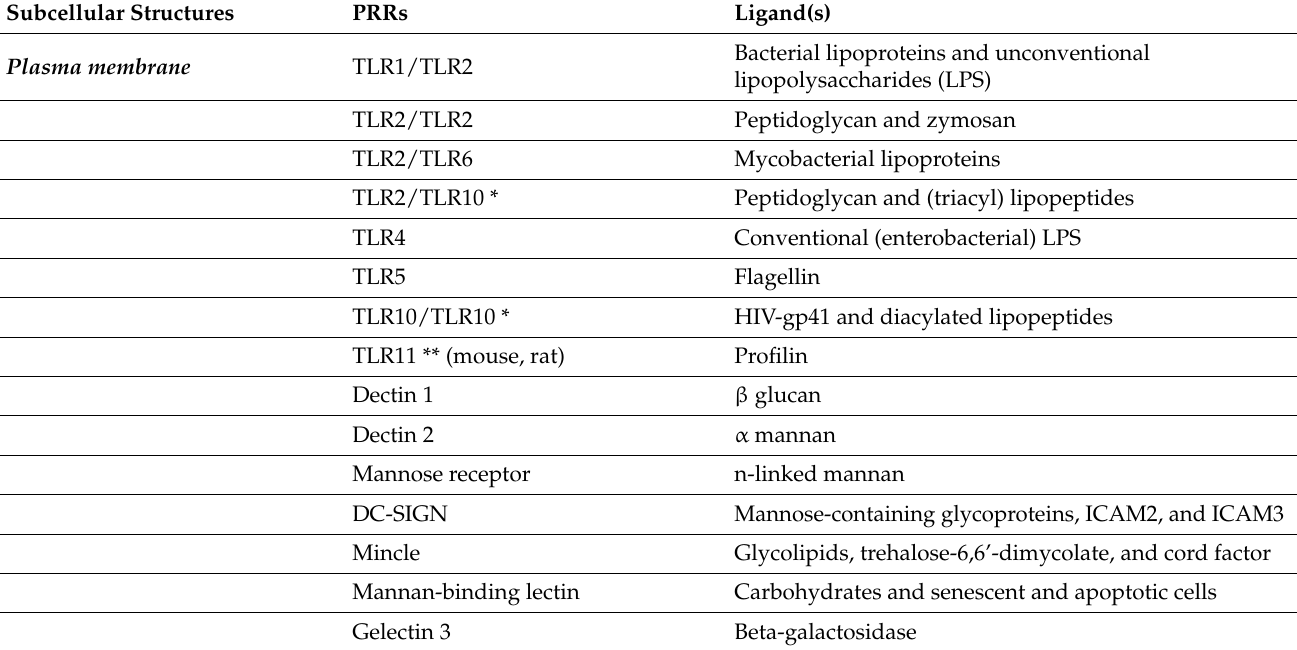
Table 1. Pattern recognition receptors and their ligands according to their relationships to subcellu- lar